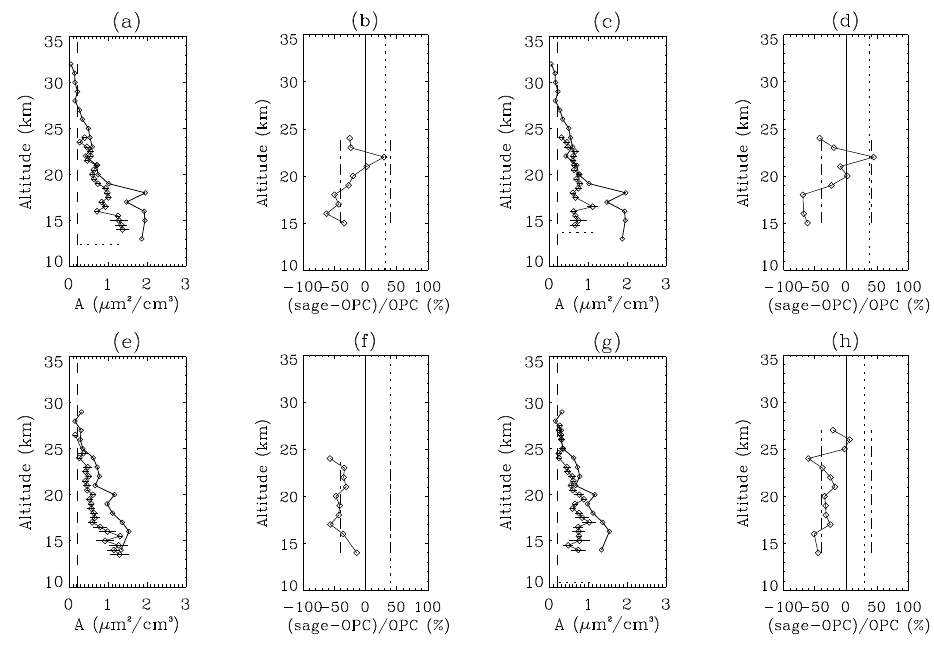
Fig. 14. Vertical profiles of surface area density. Frames (a) / (c) / (e) / (g) : Surface areas as retrieved (from SAGE data) by the NASA LaRC using the PCA approach (diamonds with error bars, measured on 22 June (a), 23 June (c), 14 December (e) and 16 December 1999 (g)) and correlative in situ (OPC) measurements (without error bars, measured on 23 June and 10 December 1999); the vertical dashed line marks the a priori mean, and the short horizontal dotted line marks the tropopause level (NMC data) at the time of the SAGE II measurements. Frames (b) / (d) / (f) / (h) : Associated relative differences. The long vertical lines mark the zero (solid) and the profile mean difference (dotted). The a priori uncertainty of 40% (Deshler et al., 2003) is marked by the dash-dotted line.